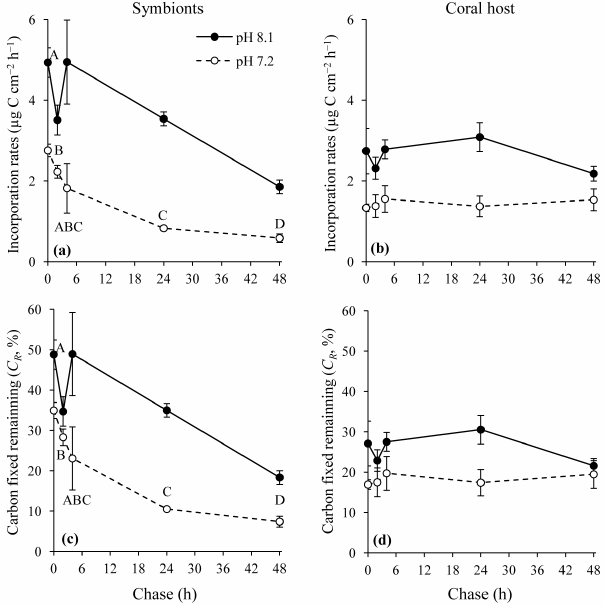
Fig. 3. Carbon incorporation rates ( ρ ) in (a) symbionts and (b) coral host. Percentage of fixed carbon that remains ( C R ) in the (c) sym- bionts and (d) host for Stylophora pistillata at pH T 8.1 and 7.2. Data are means ± standard error of means of n = 3 measurements. Chase intervals with different letters (A to D) are significantly